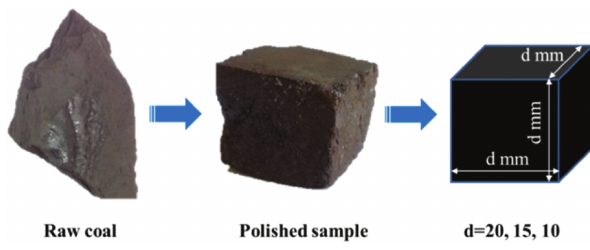
Figure 1: Coal cake size and shape for the